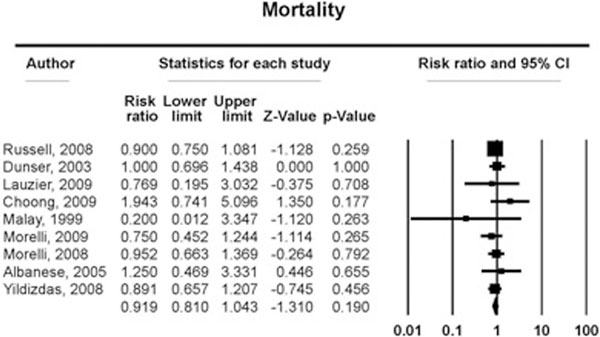
Overall mortality.